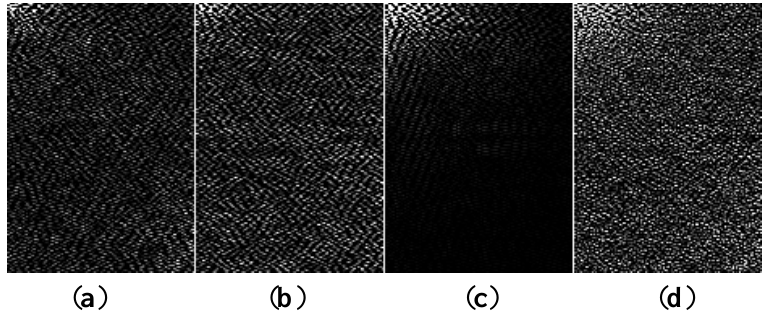
Figure 12. DCT transform of CGCI: ( a – d ) are respectively the DCTs of (a–d) in Figure 9.